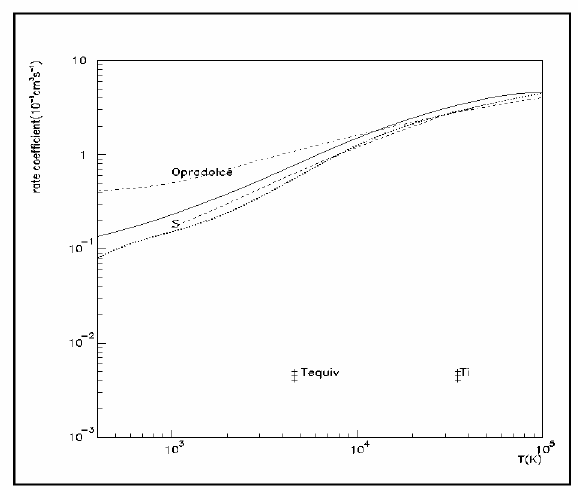
Fig. 8 : Rate coefficients as a function of temperature for Si 4+ + He. Comparison of ion trap experi- and T [15] with calculations using time-dependent (full line : Hankel-Ricatti functions ment at T i equiv [6] ; dotted line : plane wave functions [5]) or time-independent methods (S : Stancil et al. [26] ; Opra- dolce et al.